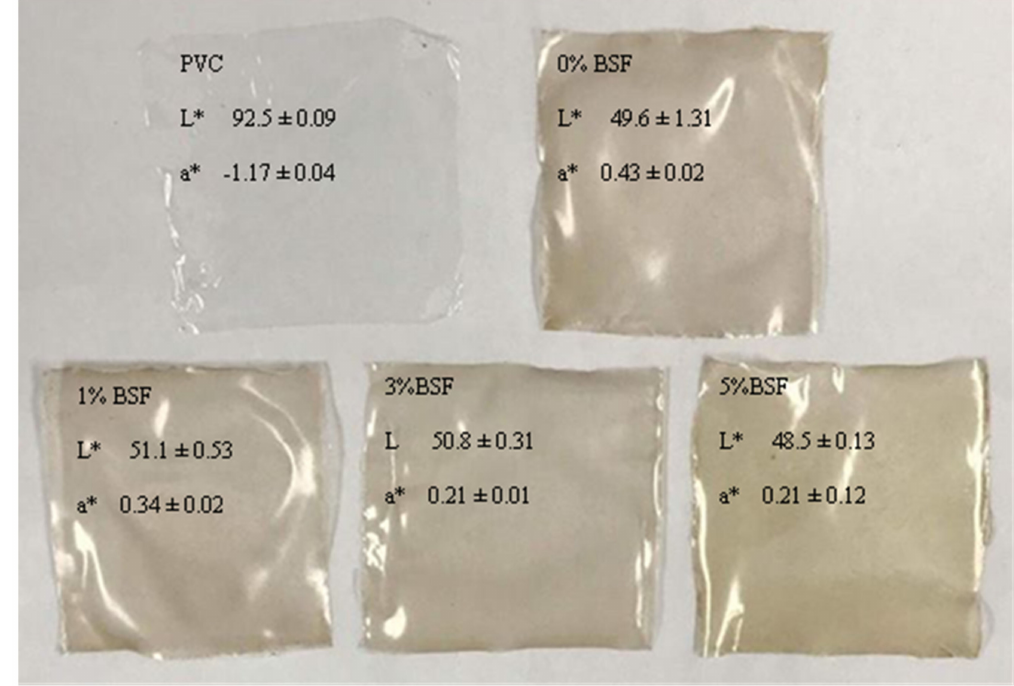
Figure 1. Appearance of banana starch films incorporated with banana peel extract with different concentrations.